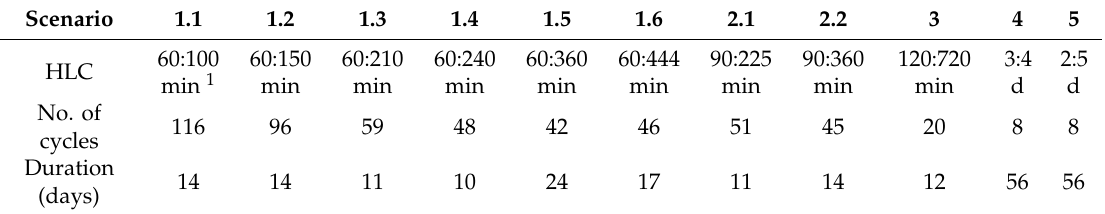
Table 2. Scenarios conducted in 6 m high soil column with di ff erent HLC (ratio wet: dry phase). Scenario 1.1